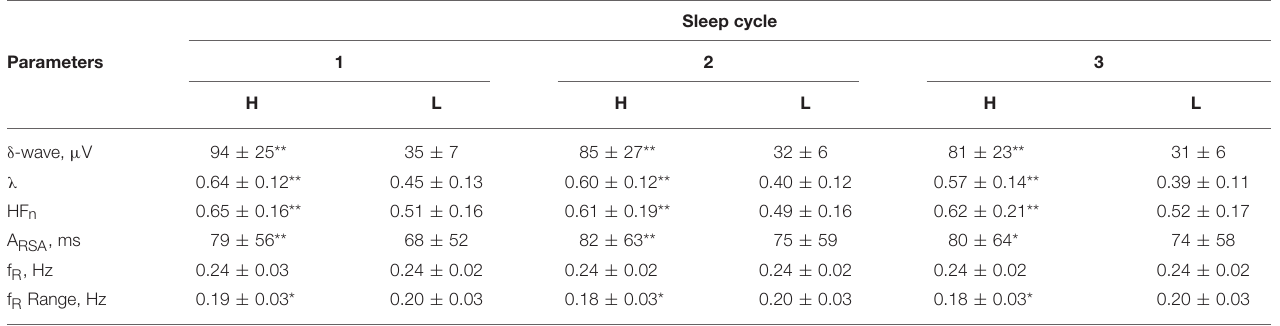
TABLE 1 | Average values of the amplitudes of δ -wave, λ , HF n , A RSA , f R , and range of f R calculated separately in the intervals of high and low δ -wave activity during 1–3 sleep cycles.